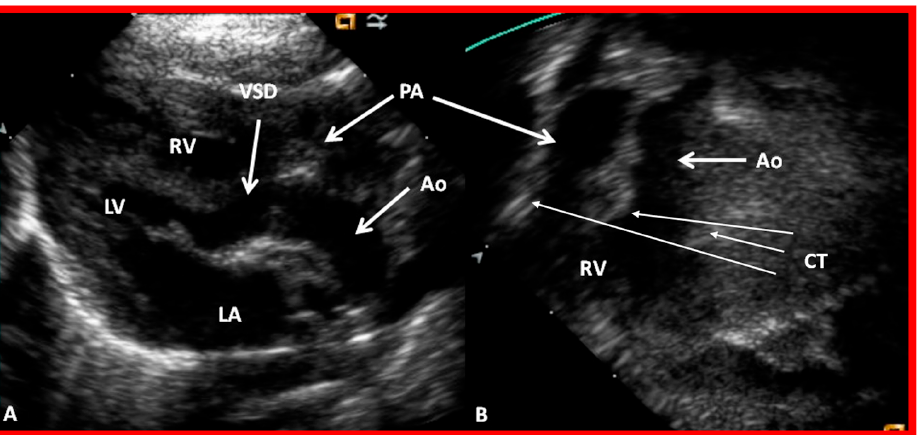
Figure 48. Echo frames from the parasternal long axis ( A ) and subcostal ( B ) views illustrating that both the aorta (Ao) and the pulmonary artery (PA) arise from the right ventricle (RV), i.e., double- outlet right ventricle. Note that the great vessels are normally related to each other. A ventricular septal defect (VSD) (vertical arrow) is also seen. The conal tissue (CT) is shown by thin arrows in ( B ). The vessel marked PA was traced further and demonstrated to subdivide into right and left pulmonary arteries. Left atrium (LA) and left ventricle (LV) are labeled. Modified from reference [43].